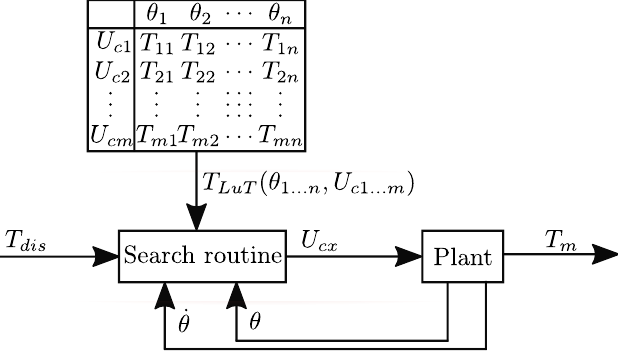
Figure 8. Schematic of open loop control for SPSDS.